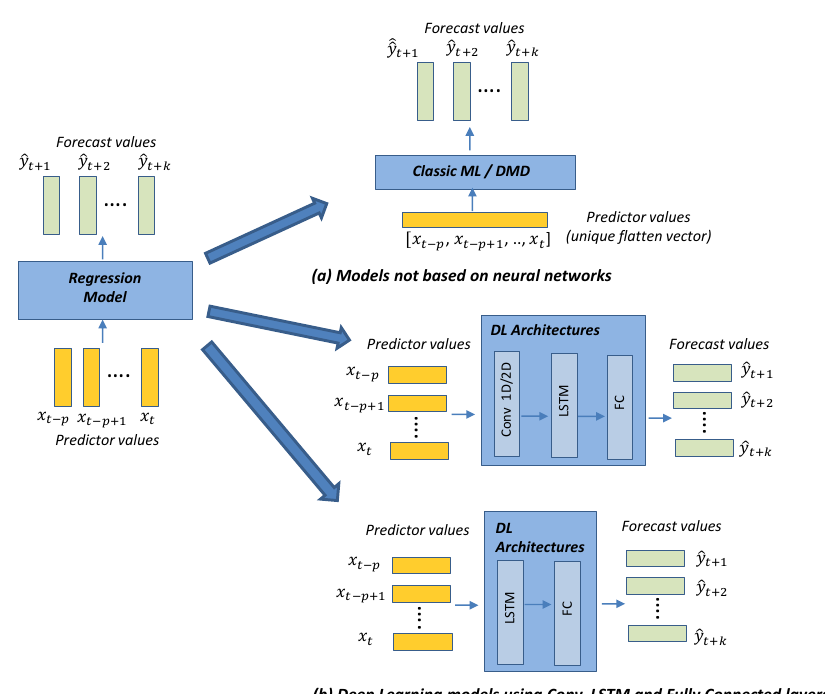
Figure 3. Detail of the models: classic ML, dynamic mode decomposition (DMD), and DL architectures.